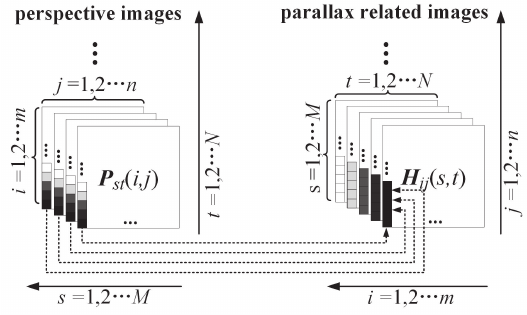
Figure 2. Transformation principle of perspective images in the infinite viewpoint camera method. (Reprinted with permission from ref [29],